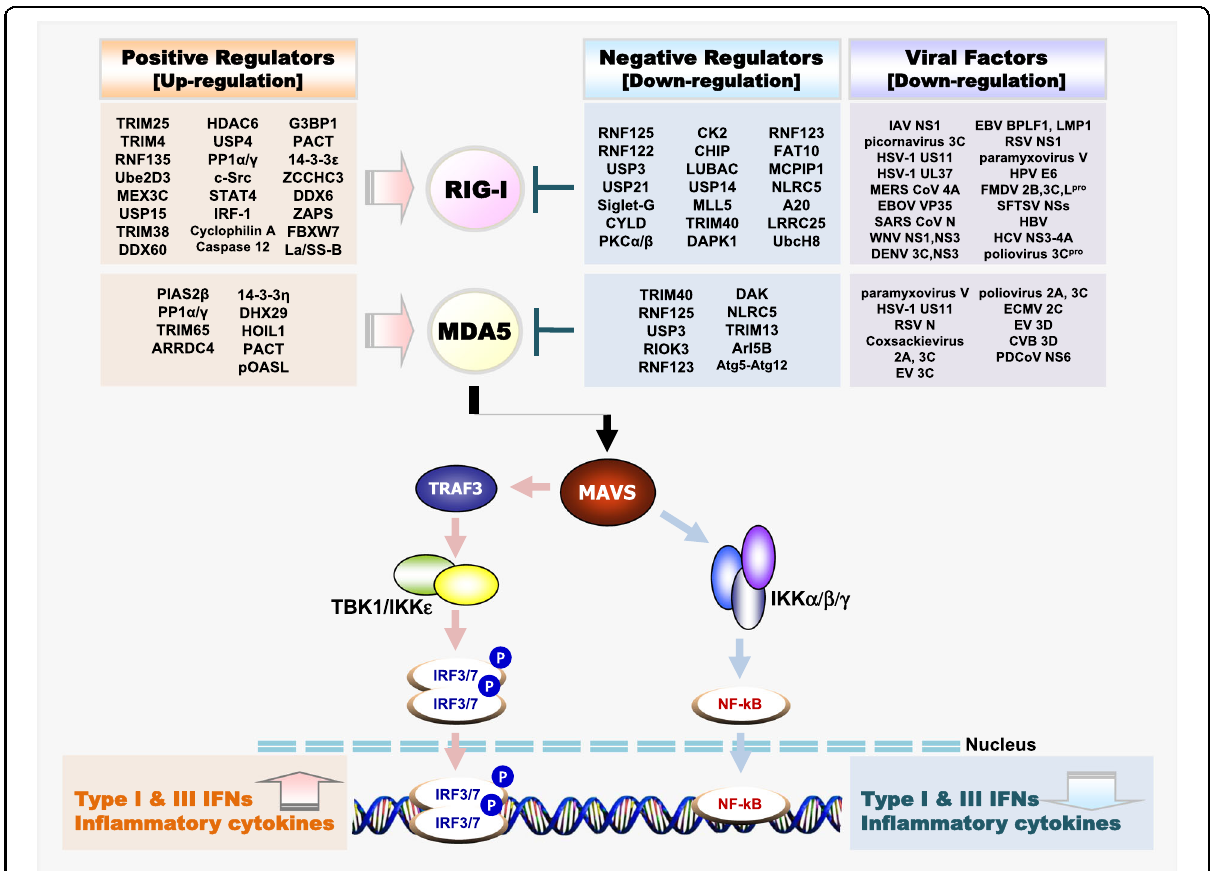
Fig. 1 Regulators and interacting viral proteins of the RLR – MAVS antiviral signaling pathway. Schematic presentation of positive and negative regulators of RLRs (Top) and melanoma differentiation-associated protein-5 (MDA5) (Bottom) through PTMs or non-PTMs and immune invasion viral proteins interacting with RIG-I (Top) and MDA5 (Bottom). The RLR-MAVS pathway includes the key cytosolic sensors RIG-I and MDA5, which detect viral RNA. These sensors subsequently interact with the central antiviral signaling protein MAVS, which in turn activates the transcription factors NF- κ B and IRF3/IRF7 via the cytosolic kinases IKK and TBK1/IKK ε , respectively. Activated transcription factors NF- κ B, IRF7 and IRF3 translocate to the nucleus and induce transcription of type I IFN and pro-in fl ammatory